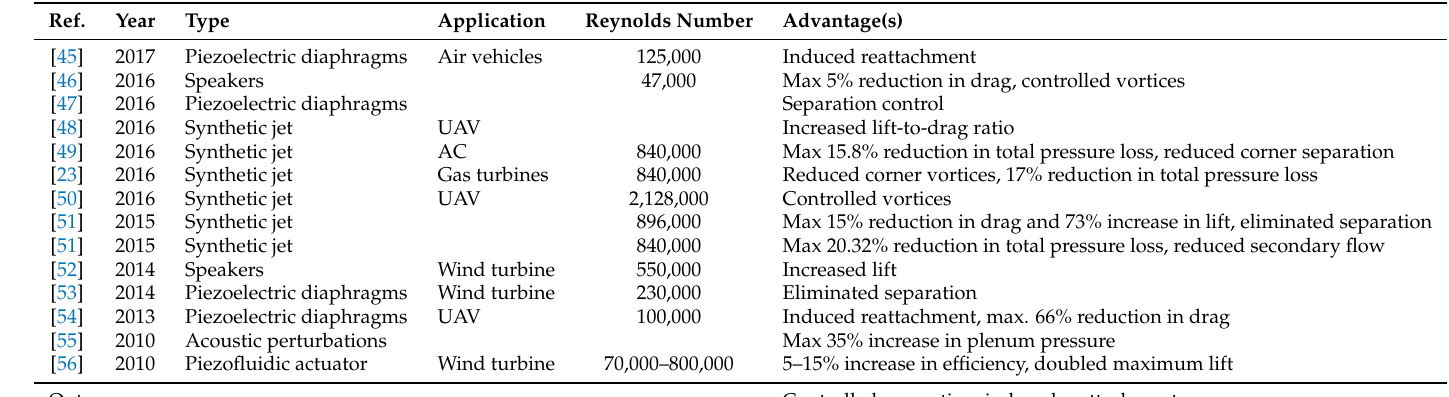
Table 4. Representative summary of synthetic jet investigations.